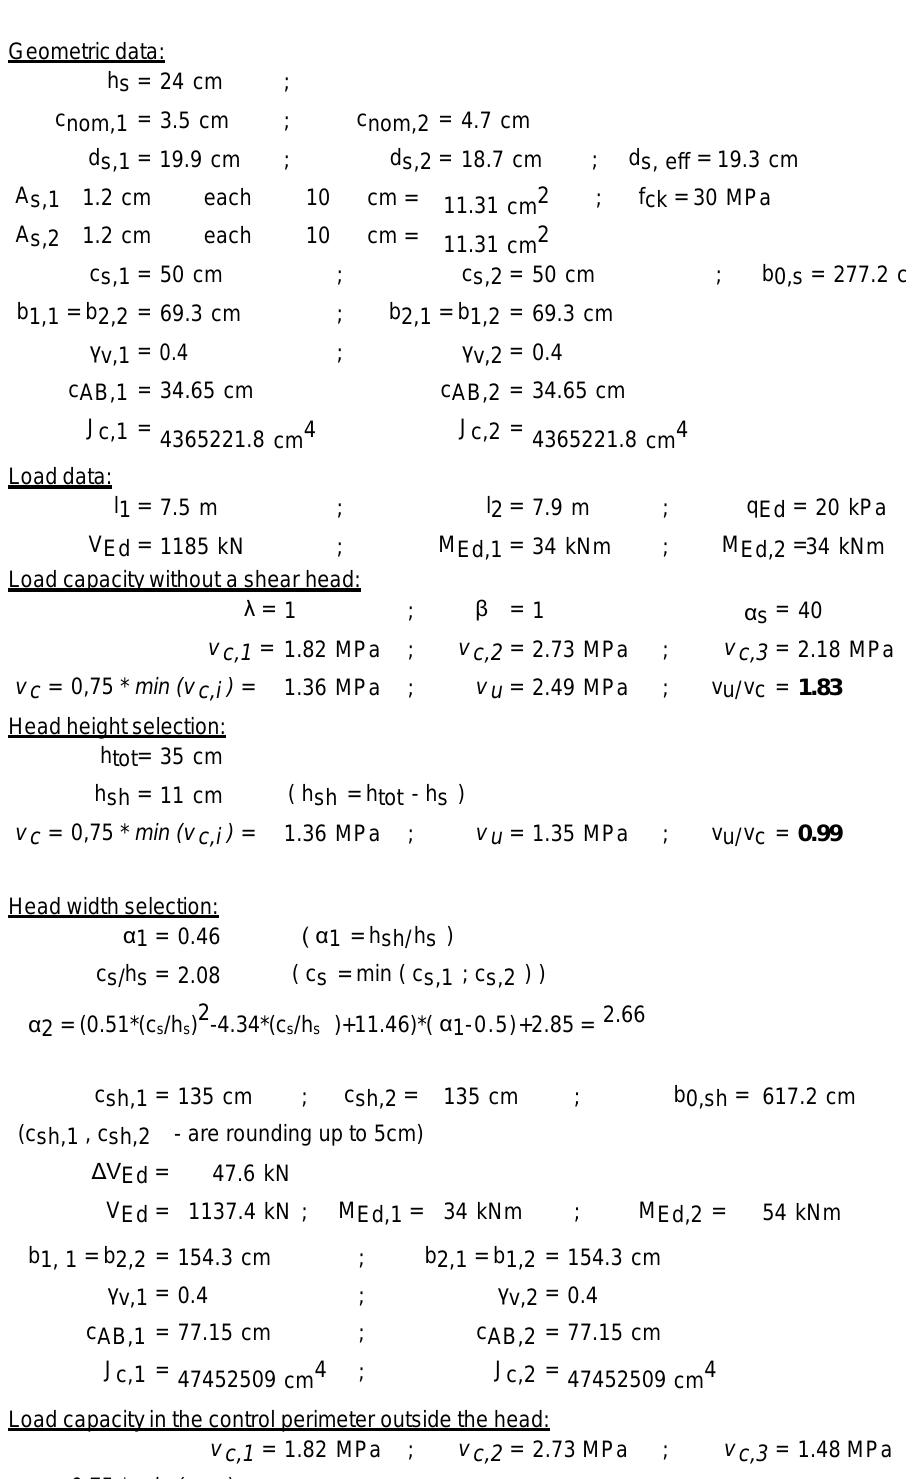
Figure A5. Verification example no. 1—ACI 318.